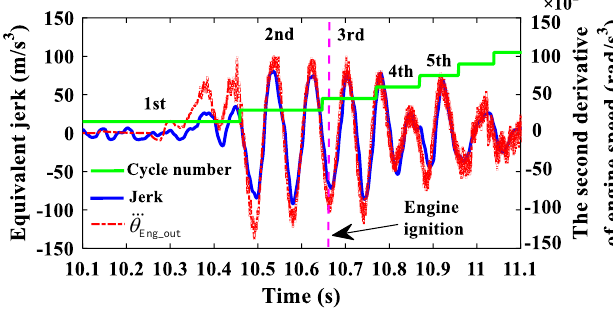
Figure 12. Jerk analysis based on engine working cycle number.